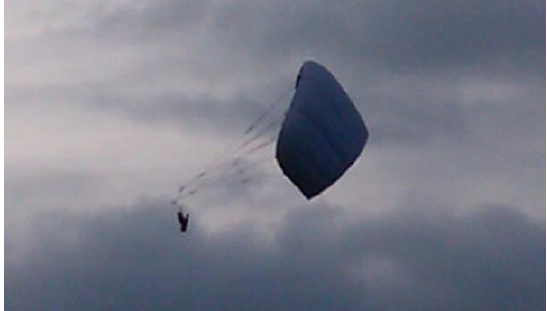
Figure 4. The kite with cradle (front). Photograph by A.K.